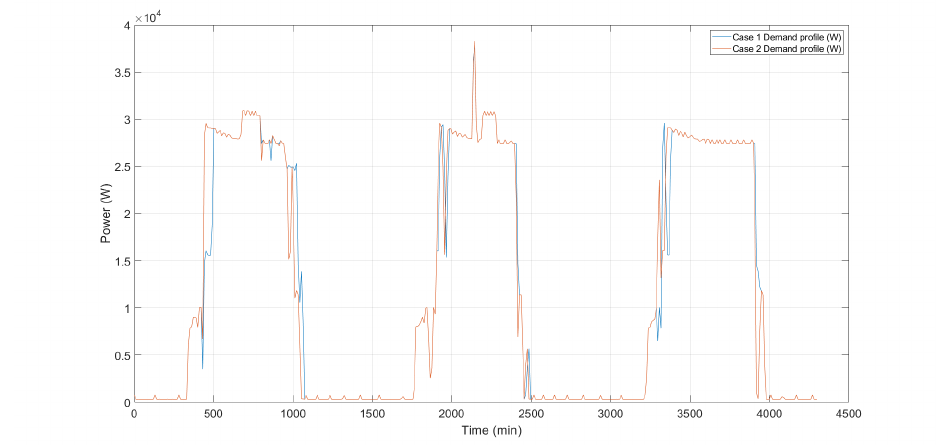
Figure 12. Energy demand profiles. Energy demand case 1 (blue) and energy demand case 2